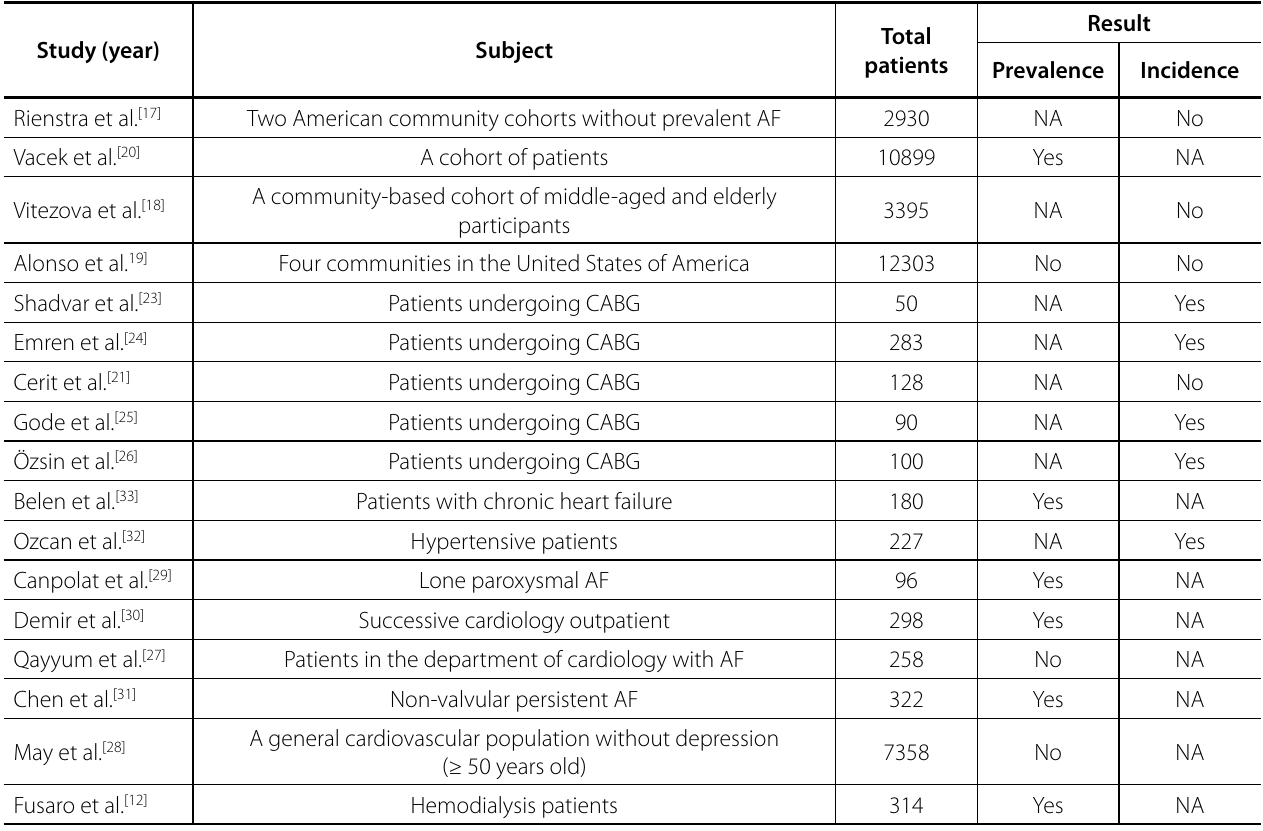
Table 1 . Epidemiological study of atrial fibrillation (AF) and vitamin D deficiency. Study